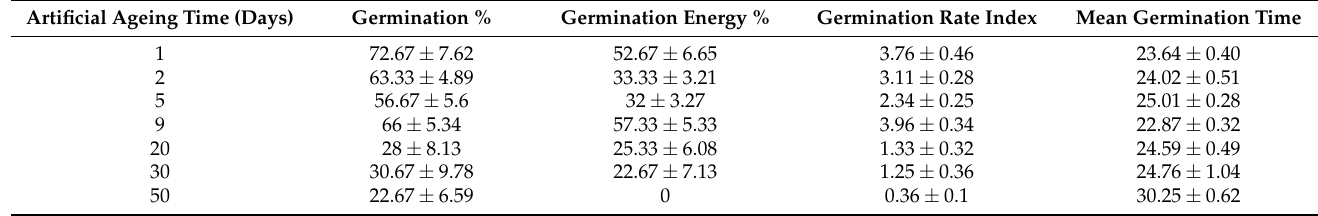
Table 1. The effect of increased exposure time to artificial ageing conditions on N. trichotoma seeds. The table shows the mean and standard error for germination (%), germination energy (%), germination rate index, and mean germination time at each duration of exposure to the treatment. As no germination was observed for 75, 100, and 120 days under artificial ageing conditions, these results were not